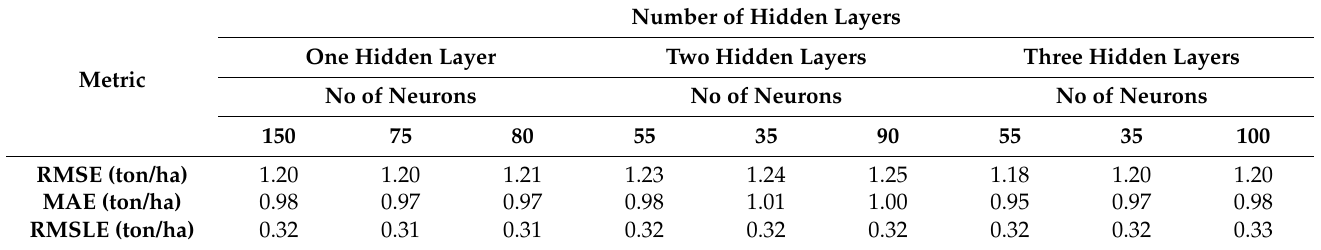
Table 5. Table showing the number of neurons of the lowest three error values for three hidden